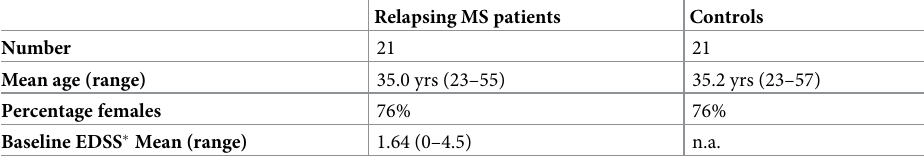
Table 1. Demographic features of the